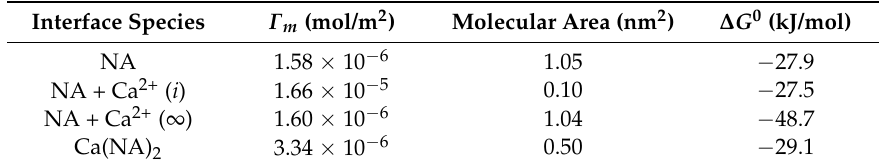
Table 1. Summary of the adsorption parameters for NA in the presence and absence of Ca 2+ ions based on the Szyszkowski